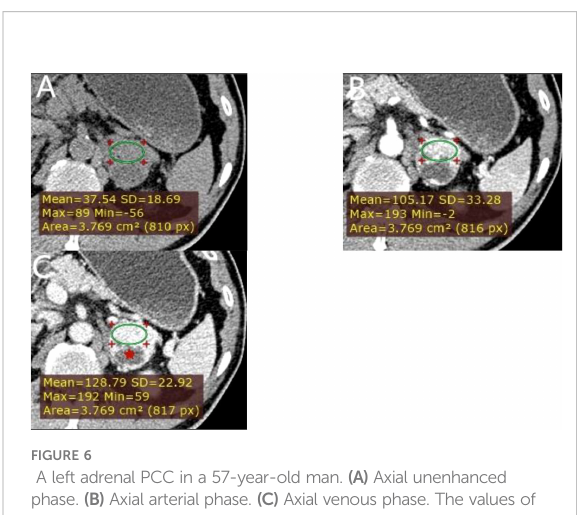
FIGURE 6 A left adrenal PCC in a 57-year-old man. (A) Axial unenhanced phase. (B) Axial arterial phase. (C) Axial venous phase. The values of CTu, CTa, CTv, and DEpeak were 37.54, 105.17, 128.79, and 91.25 HU, respectively. LD and SD of the mass were 40 and 38 mm. Cystic degeneration was seen within the Lesion (red